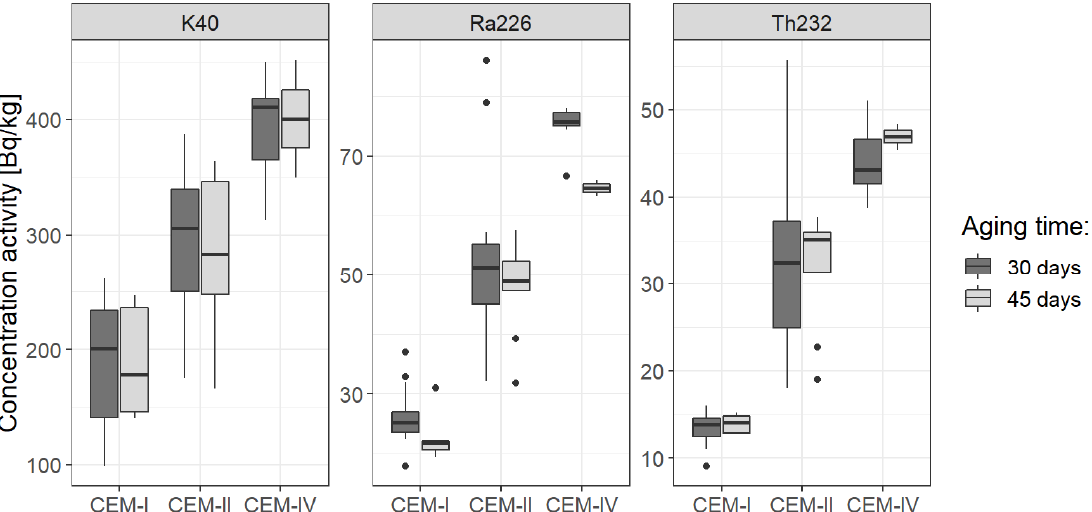
Figure 9. Comparison of activity concentration of the natural radionuclides in the case of 30-d aging vs. 45-d aging in the three types of cement: CEM-I, CEM-II, and CEM-IV. The comparison is again made with the use of box-whisker plots. This time, medians are not always the same, see discussion. The result is that there is no statistically significant difference, since p value is always greater than α = 0.05. The construction of WMW test is that only when p < α , one is able to reject the null hypothesis in favor of the alternative one which in this case sounds “the average activity concentration of a given radionuclide in the group of cement samples sealed for 45 days is lesser than in the group of samples sealed for 30 days”. When one